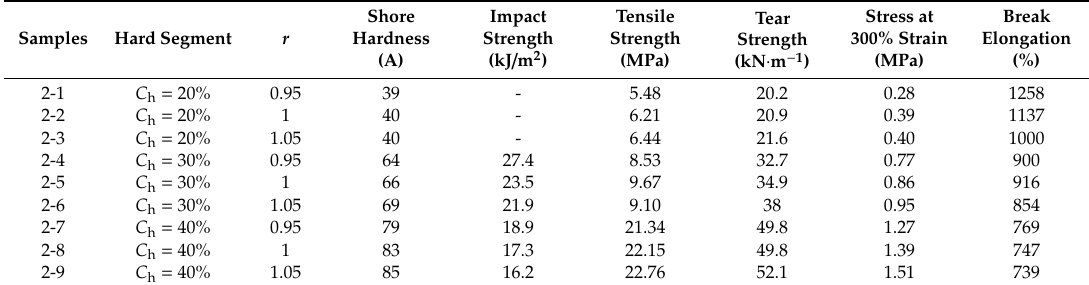
Table 12. Physical and mechanical properties of polyether-based TPUs.